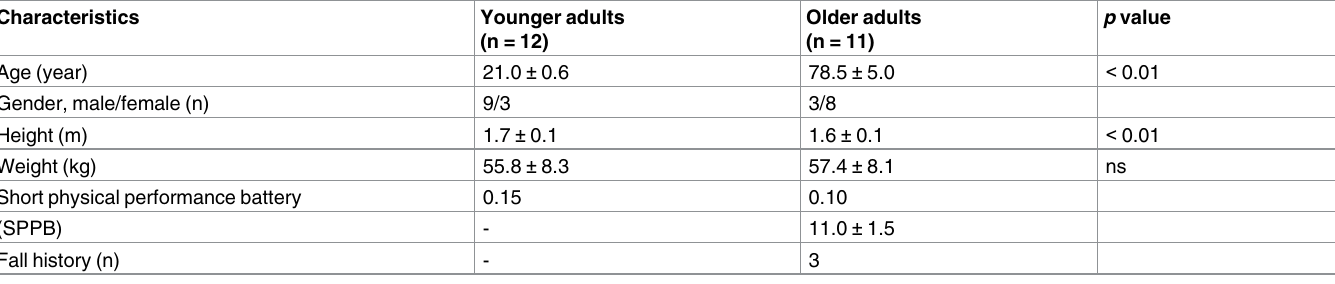
Table 1. Demographic characteristics of all